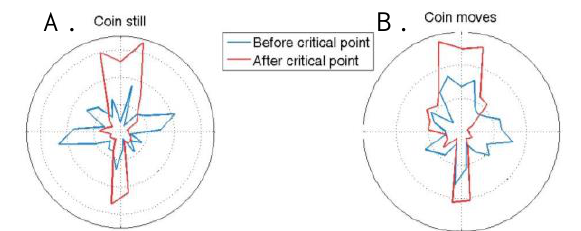
Figure 8. Polar histograms of microsaccades 700 ms before and 700 after the critical point onset. (A) Coin still condition. (B) Coin motion